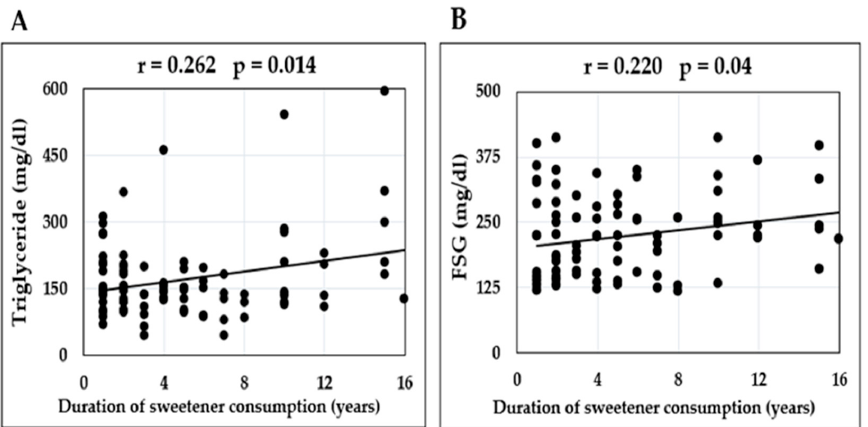
Figure 7. Pearson Correlation Coefficient I was calculated to analyze if there was a linear correlation between the duration of daily sweetener consumption and concentration of the following parame- ters in diabetic patients: serum triglycerides ( A ) and fasting blood glucose ( B ). in diabetic patients: serum triglycerides ( A ) and fasting blood glucose ( B